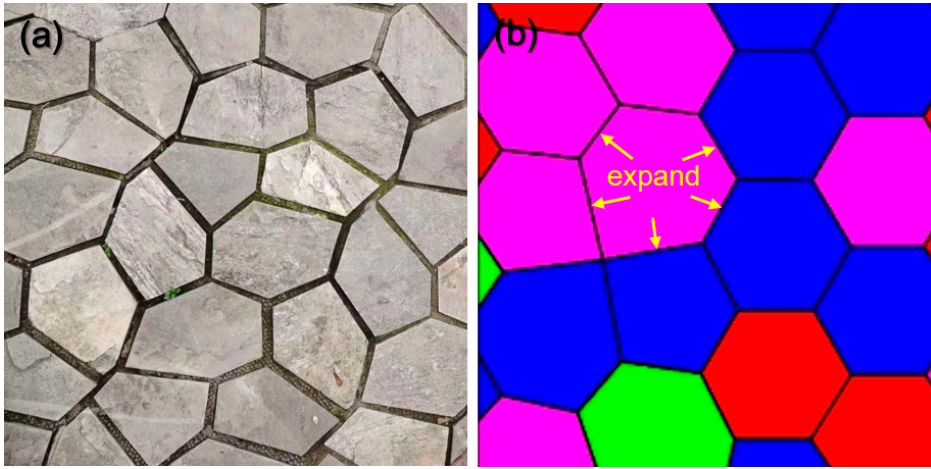
Figure 12. ( a ) Stone floor tiles, ( b ) diagram of